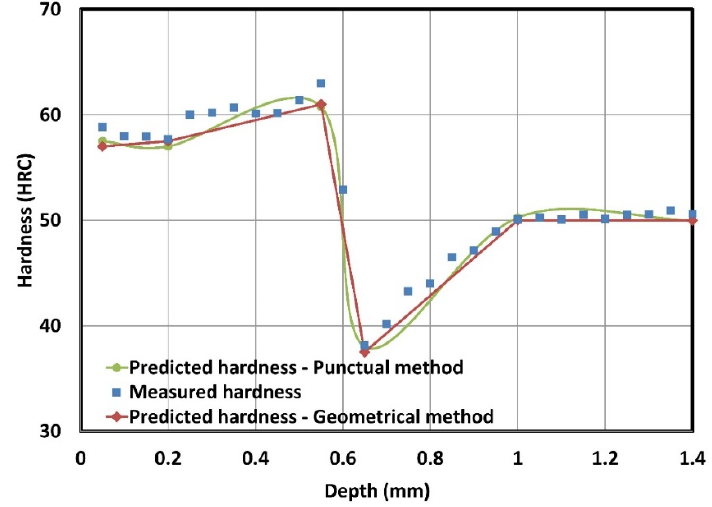
Figure 9. Measured and predicted hardness profile curves.